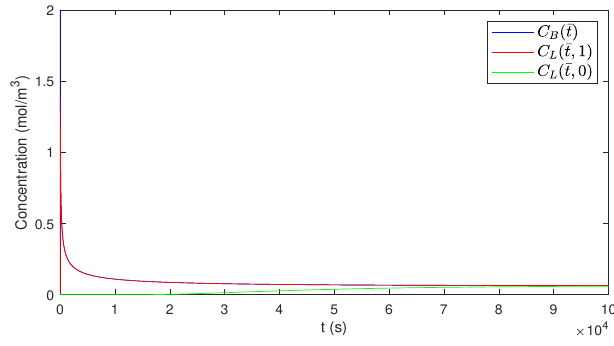
Figure 5. Dynamics of the concentrations obtained from the simplified model for the data reported in [13].